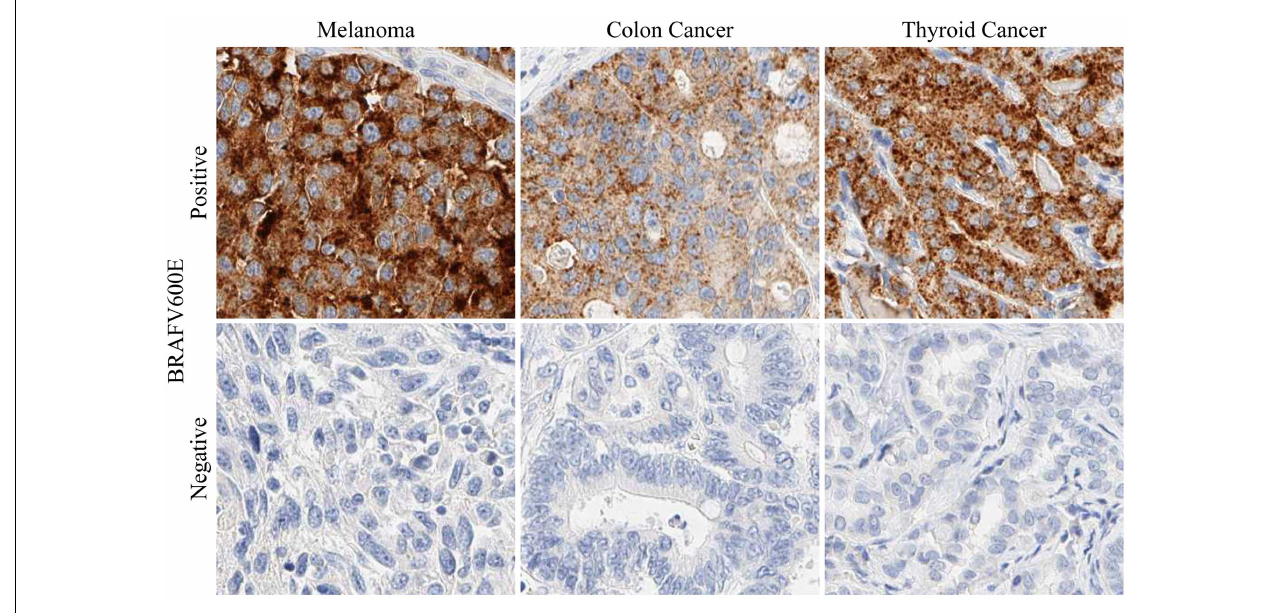
respectively. BRAFV600E-positive staining is generally detected as a granular, cytoplasmic signal that can easily be distinguished from BRAFV600E-negative cases. In the presented example images, 3,3 (cid:48) -Diaminobenzidine (DAB) was used as a